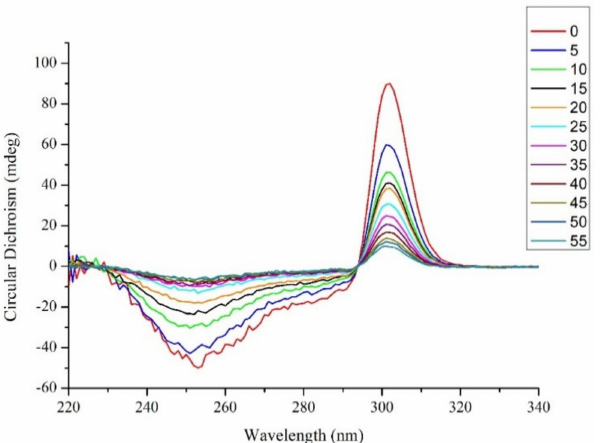
Figure 2. CD spectra of G4–CD_1 hydrogel in the 220–340 nm range recorded every five minutes from 60 to 25 ◦